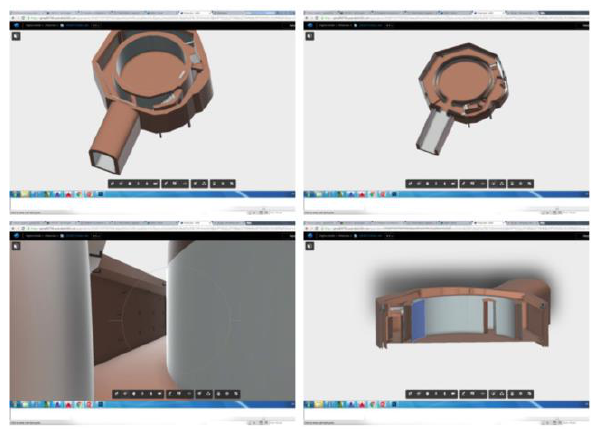
Fig. 11. The cloud-based model of the ice house in